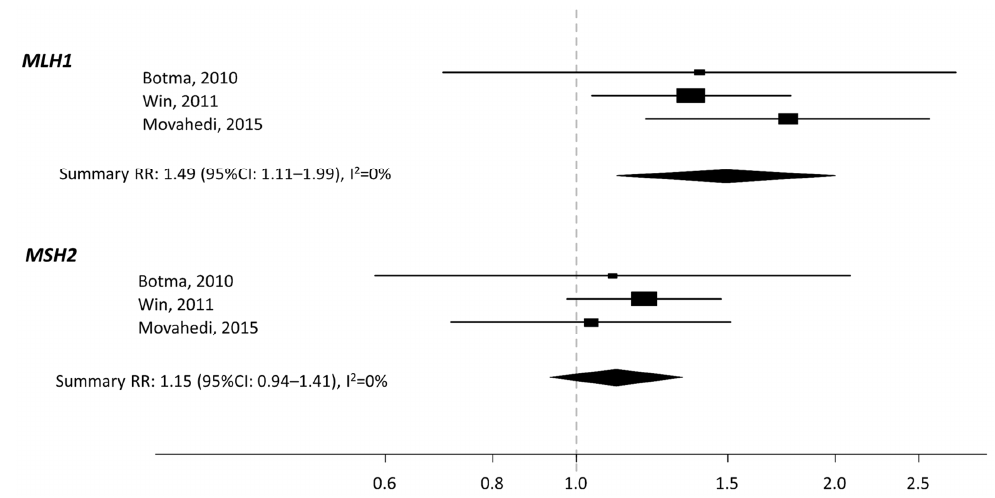
Figure 3. Forest plot of CRC risk estimate for MLH1 and MSH2 , for increasing value of BMI by 5 kg/m 2 .